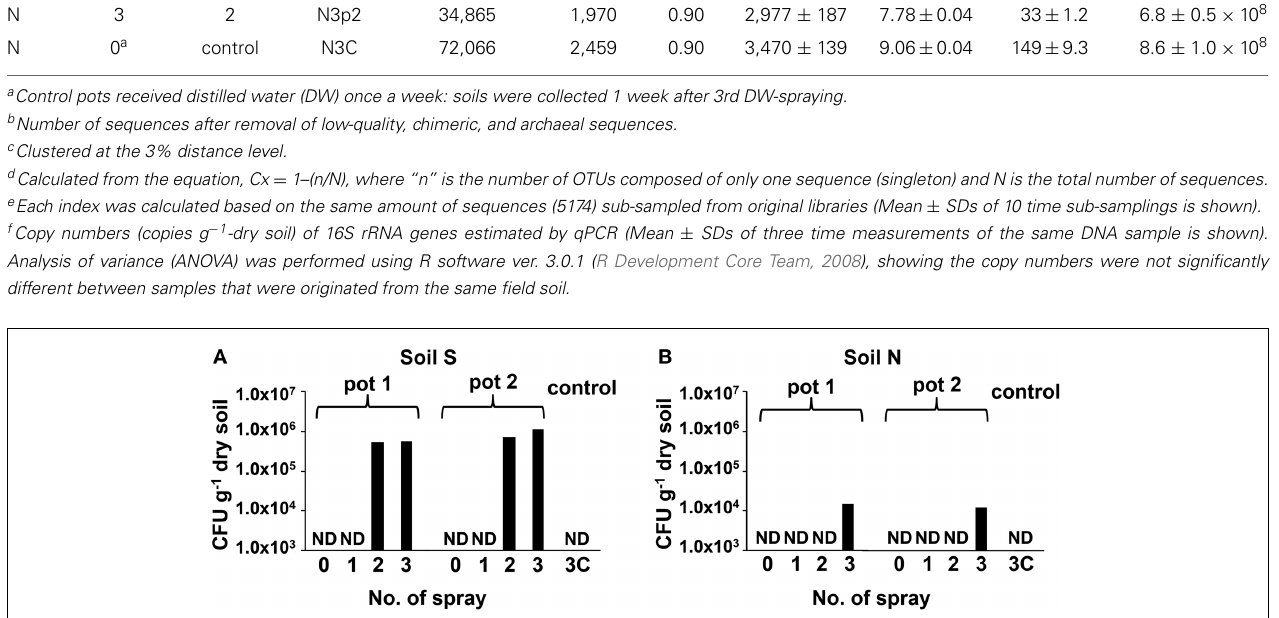
ISOLATION AND IDENTIFICATION OF MEP-DEGRADING BACTERIA From the soil S after the 2nd and 3rd MEP-treatments (S2 and S3), and soil N after the 3rd MEP-treatment (N3), colonies